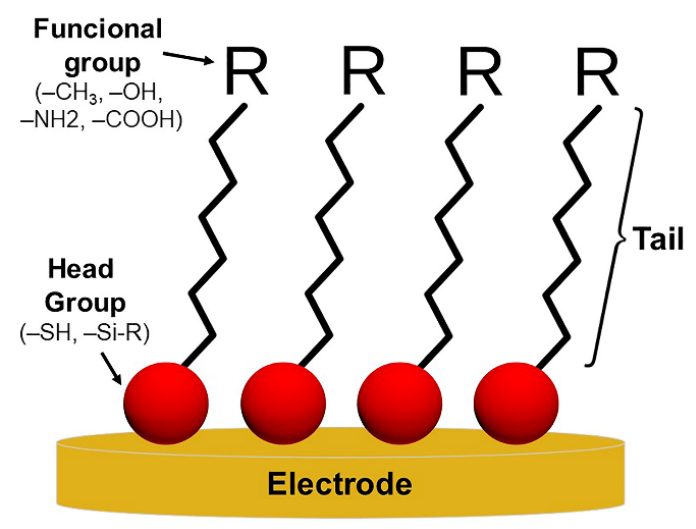
Figure 3. Generic illustration of self-assembled monolayers (SAMs).